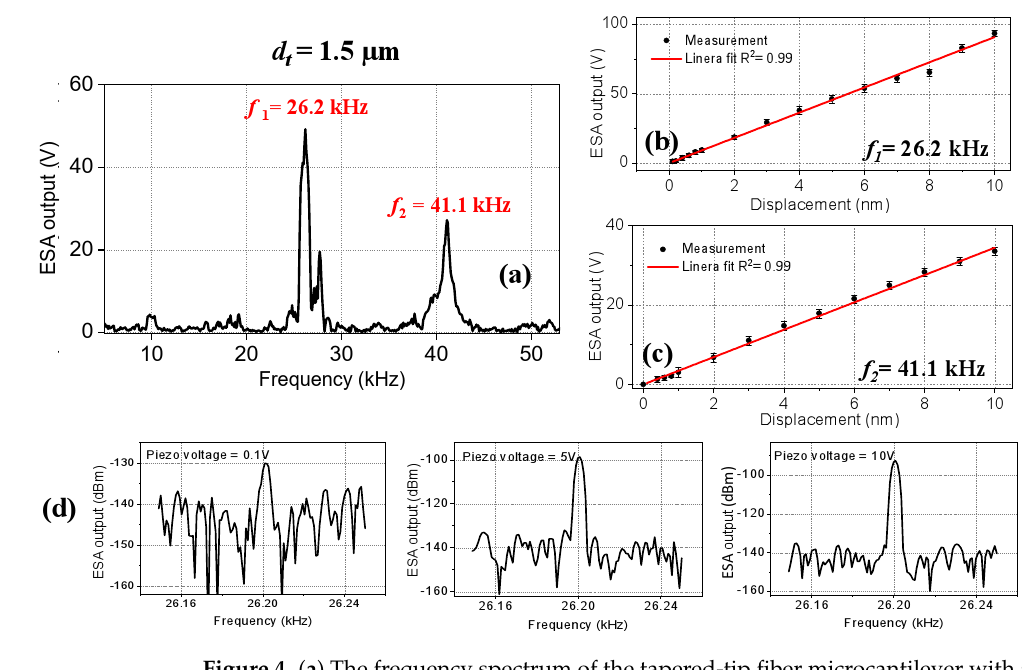
Figure 4. ( a ) The frequency spectrum of the tapered-tip fiber microcantilever with a tip diameter of d t = 1.5 µm. Two resonance frequencies were observed at f 1 = 26.2 kHz and f 2 = 41.1 kHz. The ESA output versus displacement values for ( b ) f 1 = 26.2 kHz and ( c ) f 2 = 41.1 kHz. The red line indicates the linear fit. ( d ) The ESA output spectrum at different V = 0.1 V, 5 V, and 10 V for f 1 = 26.2 kHz.